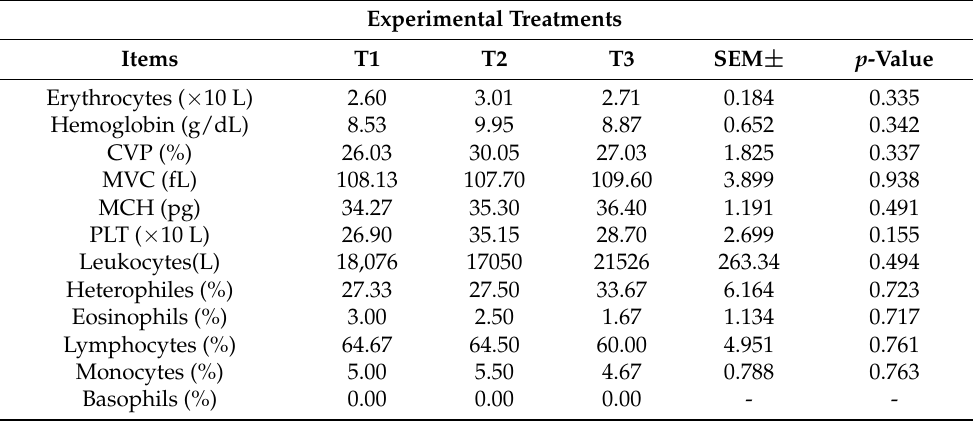
Table 5. Effect of acetic acid and sodium bicarbonate supplemented to drinking water on hematolog- ical parameters of young broilers (10